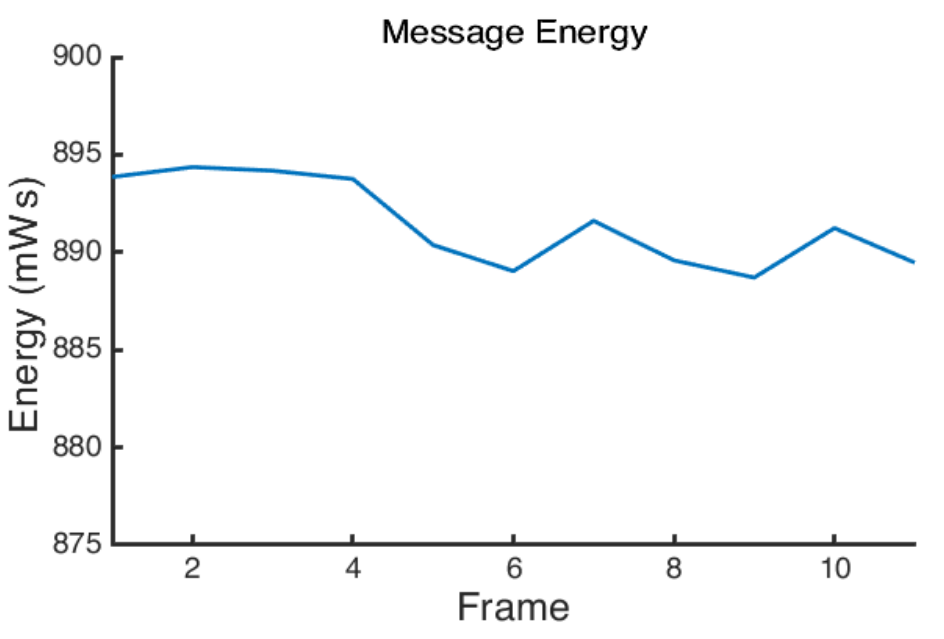
Figure 6. Energy consumed during individual frame transmission, obtained from integration of main node current capture.